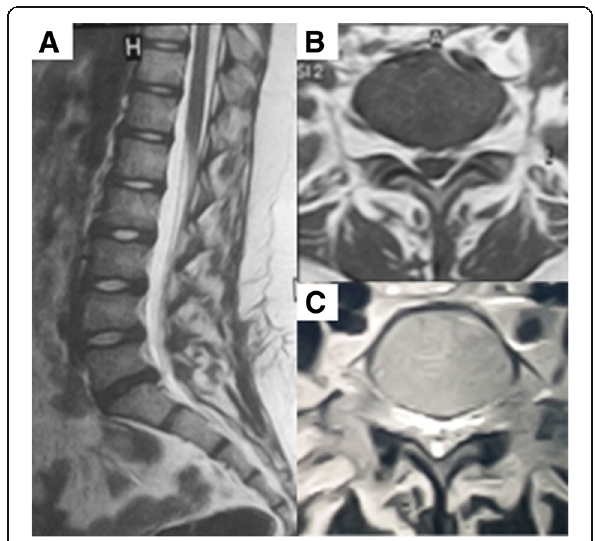
Fig. 3 Postoperative MRI of the lumbosacral spine. a Sagittal T2. b Axial T1. c Axial